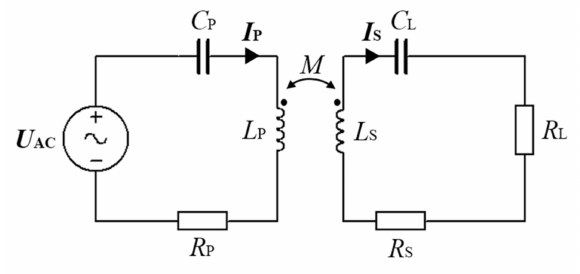
Figure 1. Circuit diagram of S-S compensation